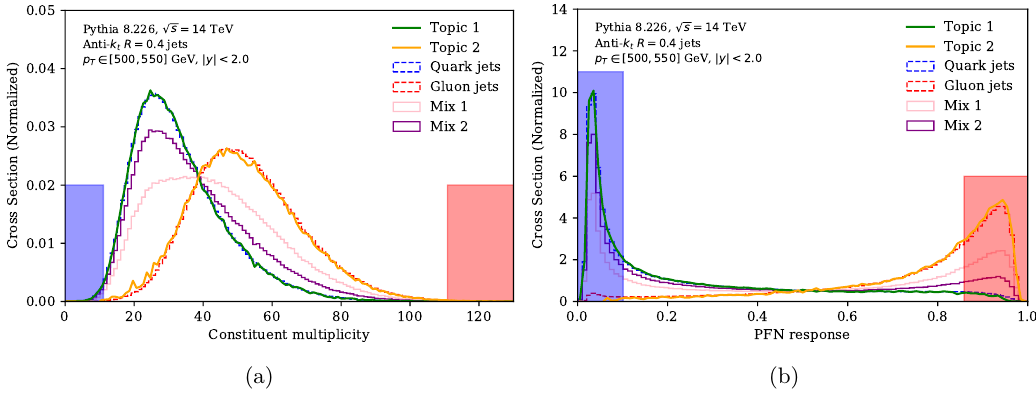
Figure 2 . The distributions of (a) the constituent multiplicity distribution, and (b) the output of a particle flow network trained to classify quark and gluon jets are shown for the mixed samples with 80% (pink) and 50% (purple) quark jets, with the pure quark (blue) and gluon (red) distributions from Pythia and the extracted jet topics (green and orange). The anchor regions used to define quark- and gluon-enriched samples for the topics extraction are indicated by blue and red rectangles at the left and right side of the